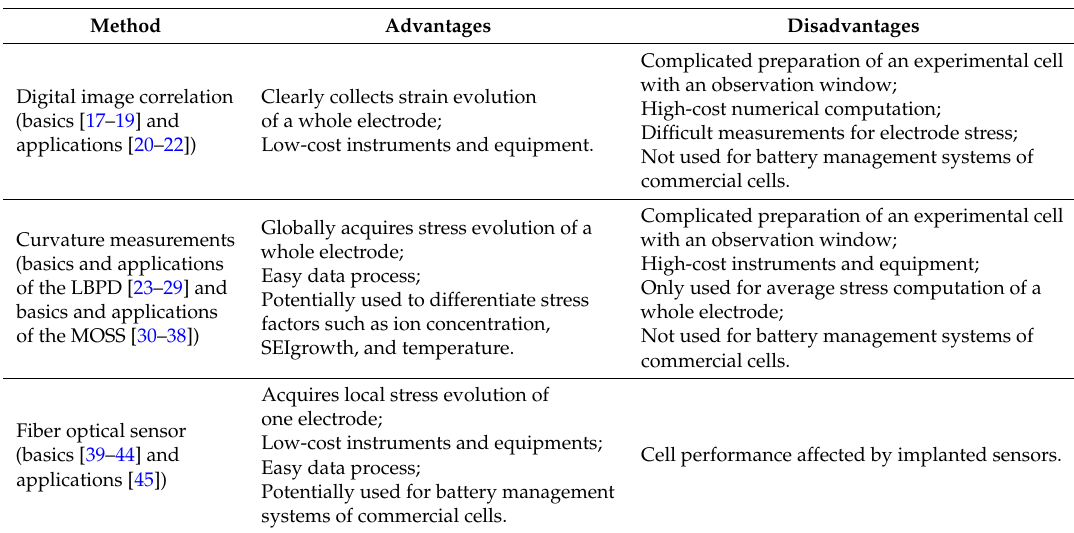
Table 1. Assessment of in situ stress measurement methods for Li-ion battery electrodes.